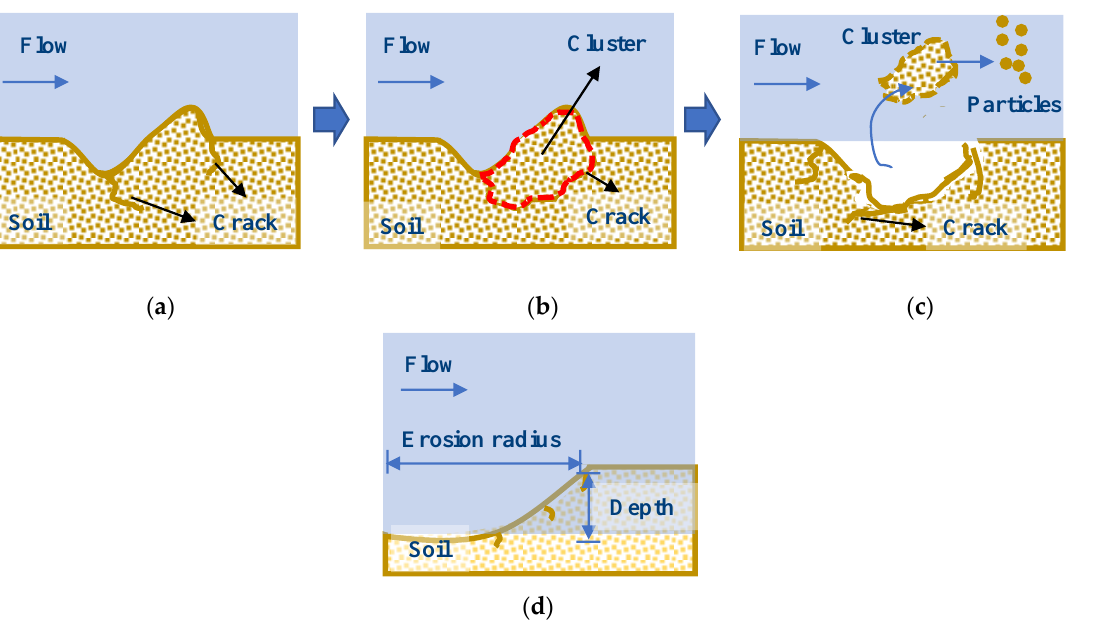
Figure 15. Evolution of erosion of solidified soil (initial setting). ( a ) Erosion line formation ( b ) Erosion line extension/penetration ( c ) Local intense erosion ( d ) Erosion equilibrium.